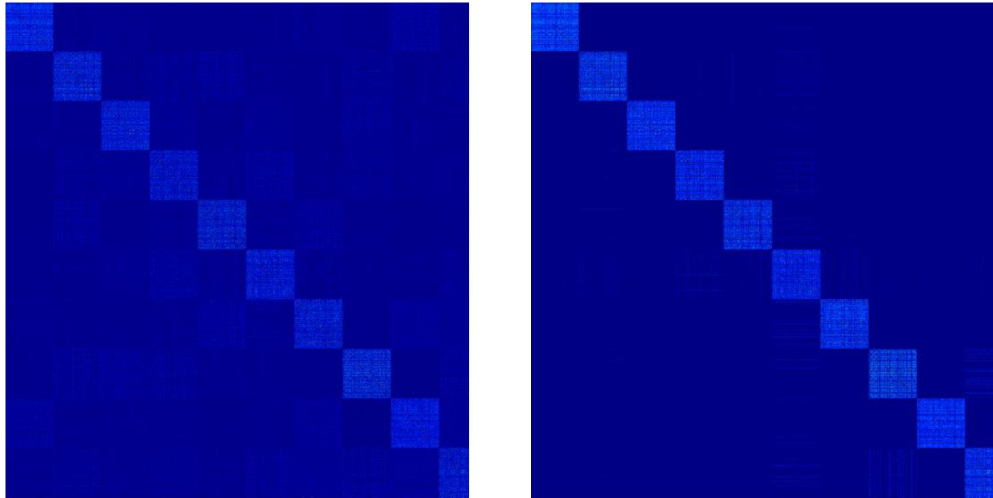
Fig 10. Visual analysis of unified matrices U 1 and U 2 on HW.